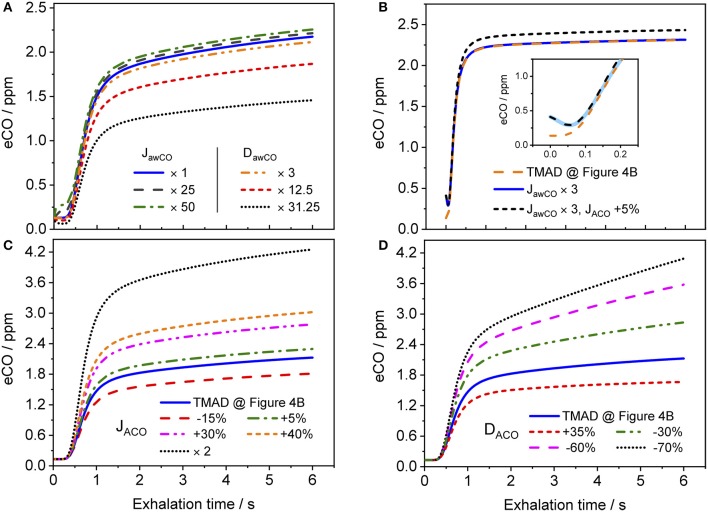
Simulated eCO profiles for variations in (A) maximum airway flux or airway diffusing capacity, (B) maximum airway and alveolar fluxes simultaneously (including 10 s BH), (C) maximum alveolar flux, and (D) alveolar diffusing capacity. The inset in (B) shows a close-up on the first 0.25 s of the exhalation, with the abscissa in terms of exhalation time. Initial TMAD parameters are similar to those used for the simulation in Figure 4B. The exhalation flow rate and the exhaled volume are 121 ml/s and volume 726 ml, respectively. Parameter units as in the nomenclature.